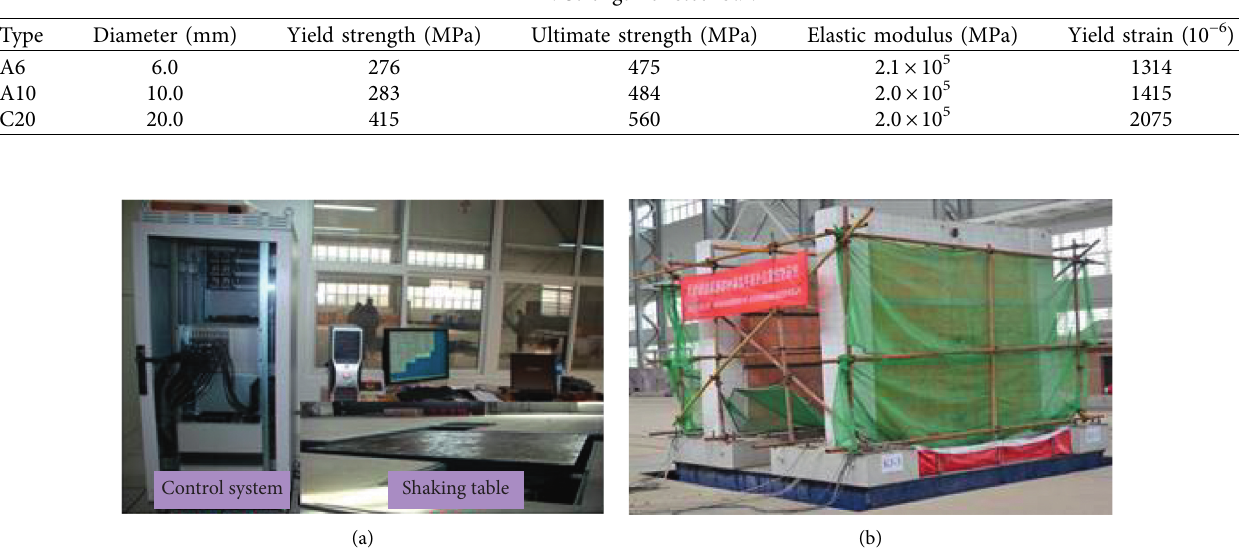
Figure 6: Shaking table system and specimen. (a) Shaking table system. (b) Specimen.